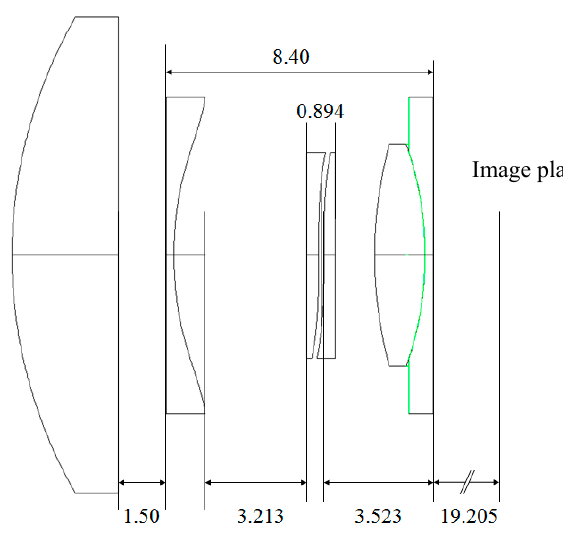
Figure 6. Optical model of the AAS.